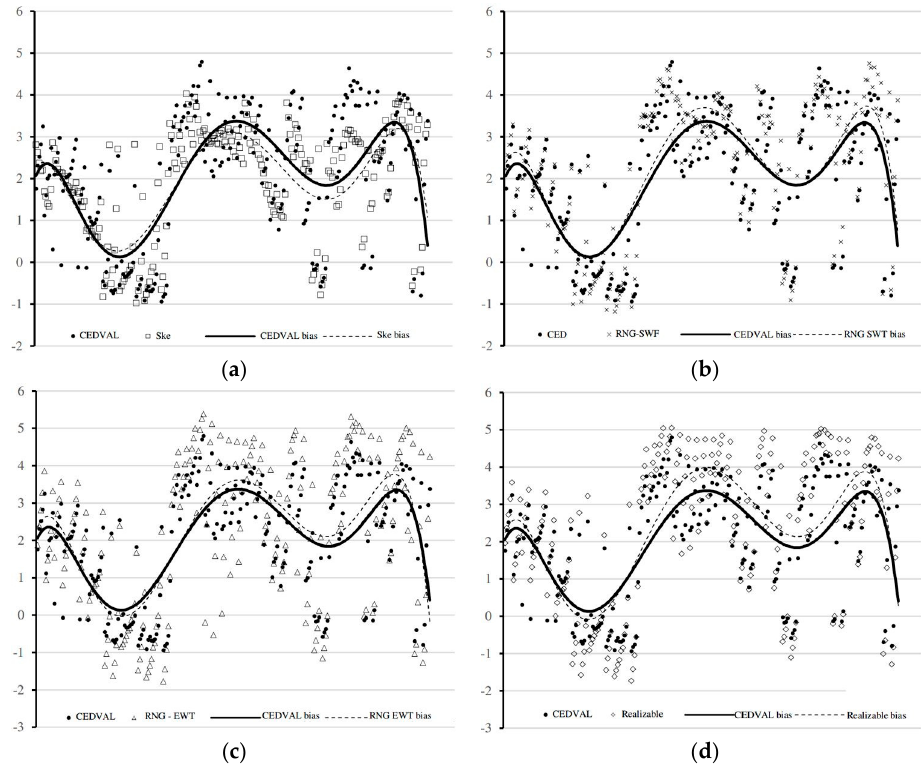
Figure 3. Sampling-point results (accuracy %) from the CFD validation model compared with A1–4 CEDVAL case results. ( a ) Sk ε ; ( b ) RNG-standard wall functions (SWF); ( c ) RNG-enhanced wall treatment (EWT); and ( d ) Realizable.